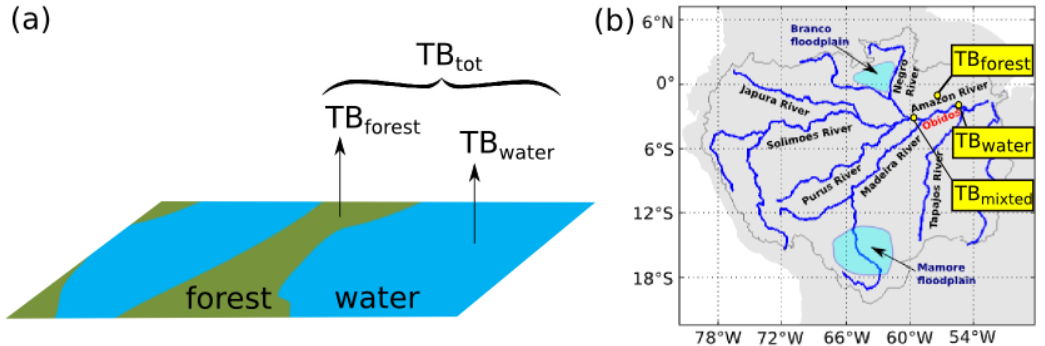
Figure 3. ( a ) Pixel representation with the two contributions: forest and water; ( b ) location of the “water”, the “forest” and the mixed